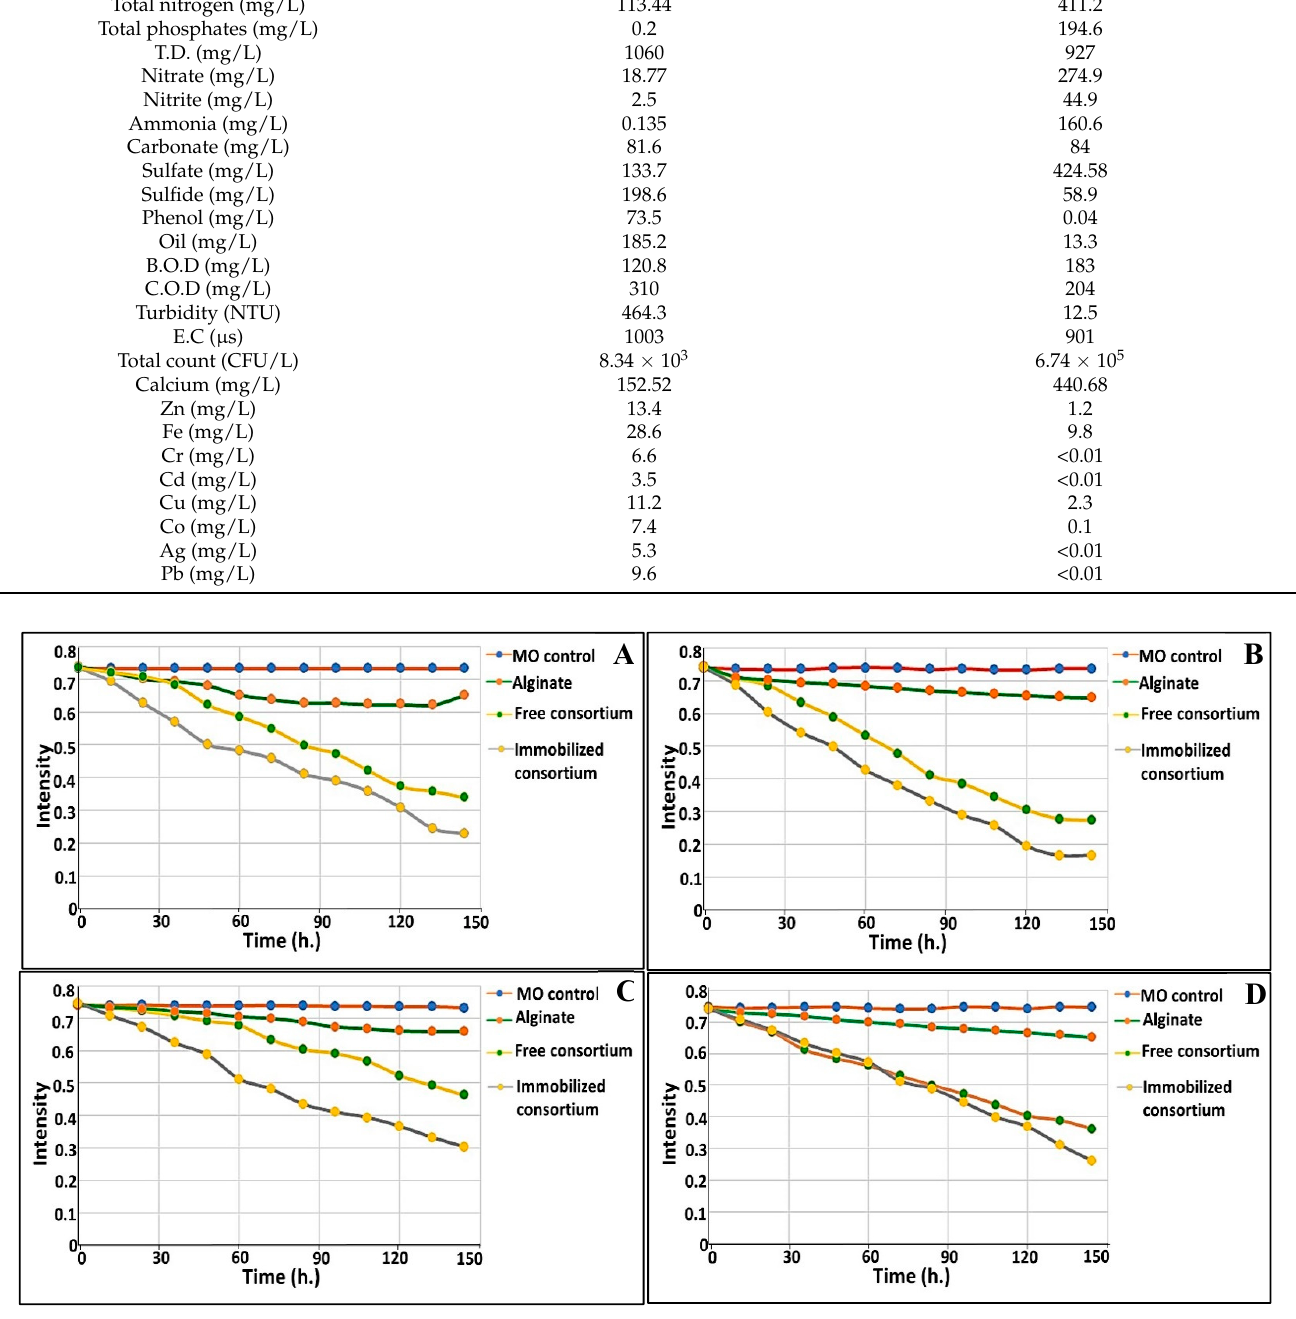
Figure 7. MO bioremediation from agricultural and industrial effluents using microbial consortium either freely suspended or immobilized in both augmented and non-augmented states: ( A ) non- augmented state of agricultural effluent; ( B ) augmented state of agricultural effluent; ( C ) non-aug- mented state of industrial effluent; ( D ) augmented state of industrial effluent.